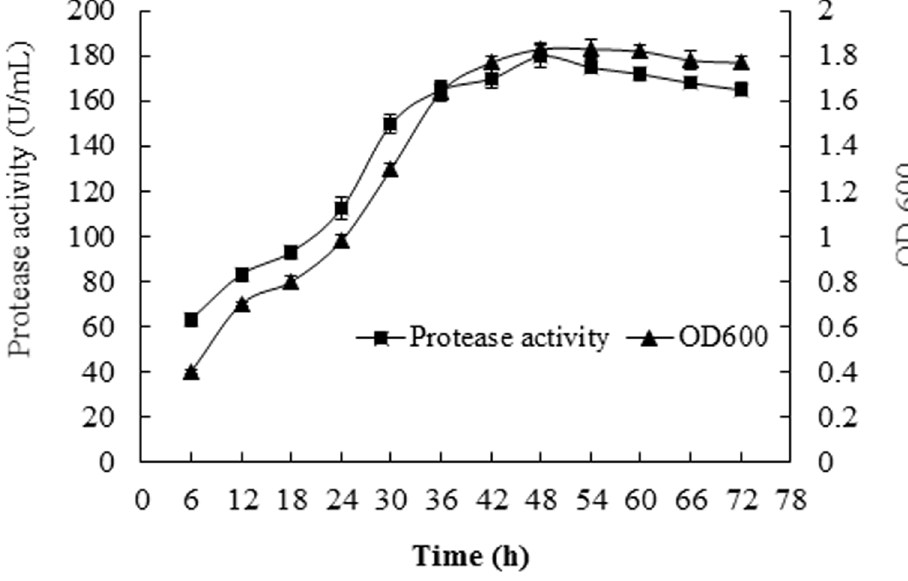
Fig 6. Effects of culture time in influencing the production of alkaline protease and growth from strain SD8. The optimum medium was used. All the data were given as means ± SEM (n = 3).